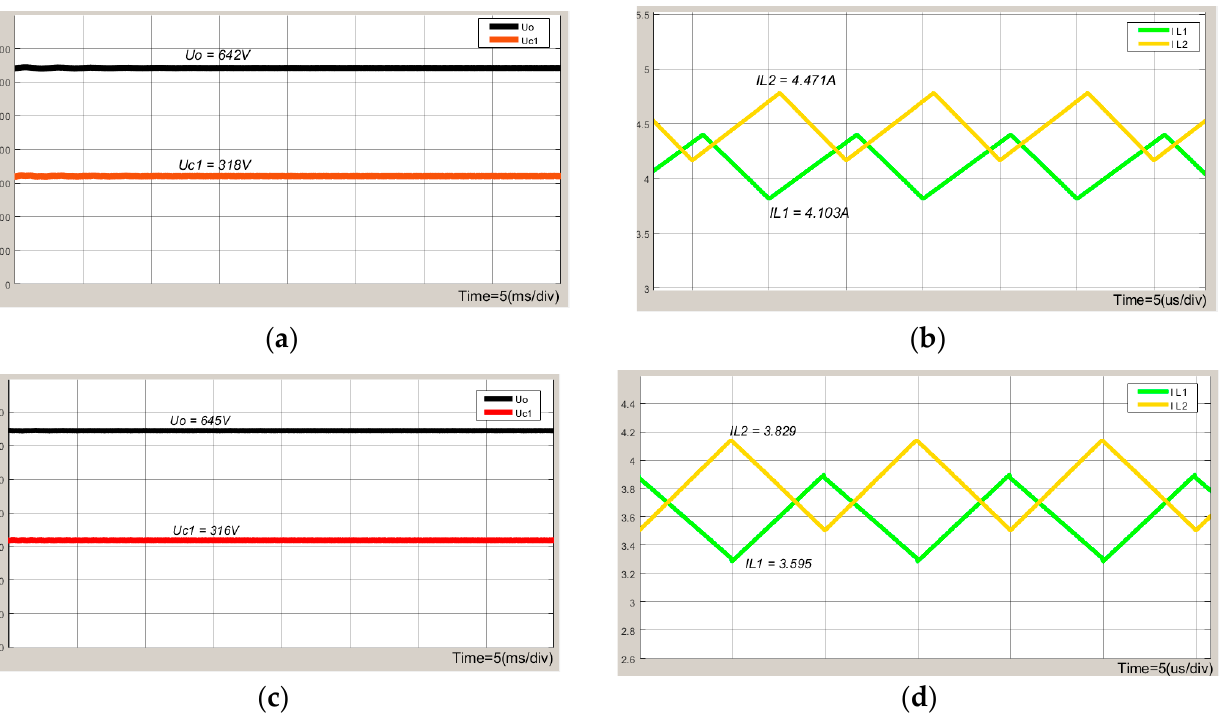
Figure 8. The simulation results of state 1 and 2: ( a ) the voltages of output and capacitor in state 1; ( b ) the average currents and their waveforms of inductors L 1 and L 2 in state 1; ( c ) the voltages of output and capacitor in state 2; ( d ) the average currents and their waveforms of inductors L 1 and L 2 in state 2.